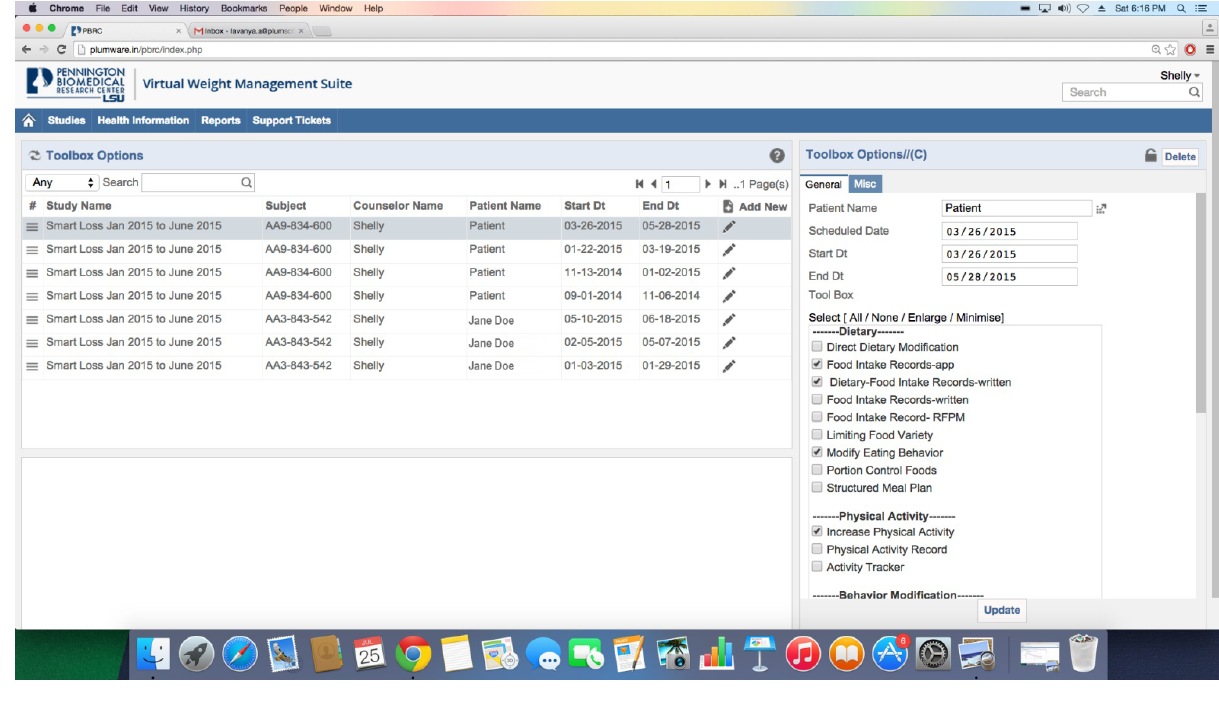
Figure 5. Screenshot of the SmartToolbox section of the clinician dashboard. SmartToolbox options are utilized when clients require additional support to meet their goals. Less intense and usually more affordable options are used first and progress is tracked to determine if improvement occurred. If not, more intense and usually more costly options are utilized and progress is similarly tracked. The clinician dashboard automatically tracks toolbox use and reports can be generated to demonstrate which options were utilized, as well as change in weight and exercise levels during use of the different toolbox